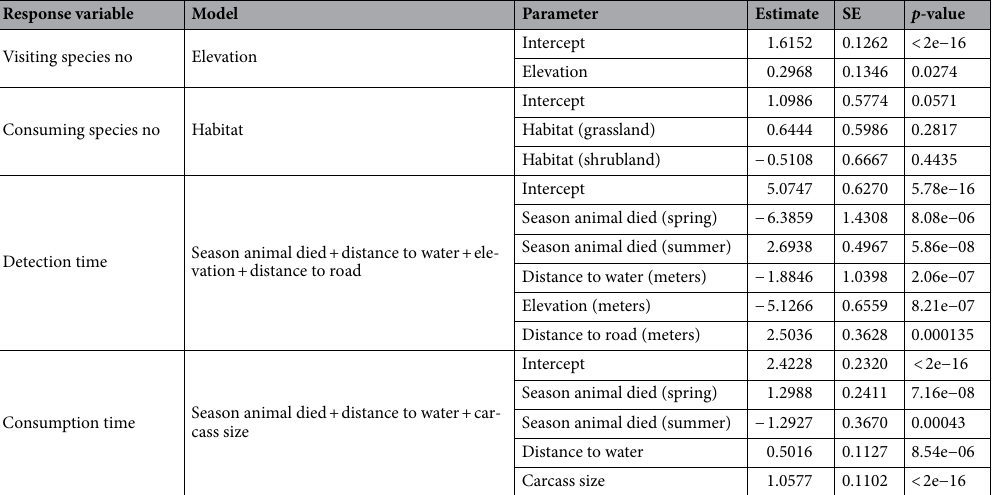
Table 2. Top-ranked GLMs showing the relationship between visiting and consuming species numbers, scavenging efficiency (detection time and consumption time), and the following predictor variables: carcass size, elevation, season of animal death, distance to water, and distance to